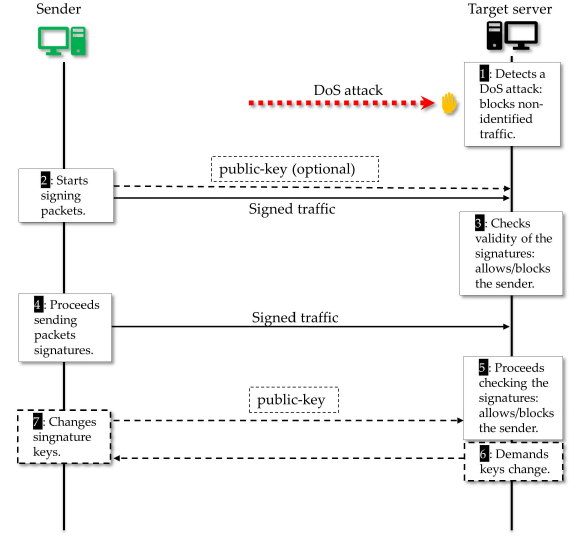
Figure 8. Overview of the proposed defense dynamics showing the interaction between sender and